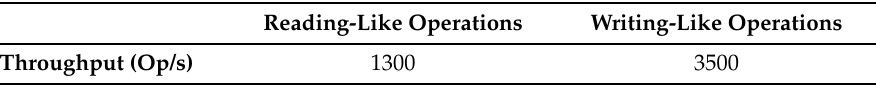
Table 2. Throughput performance.